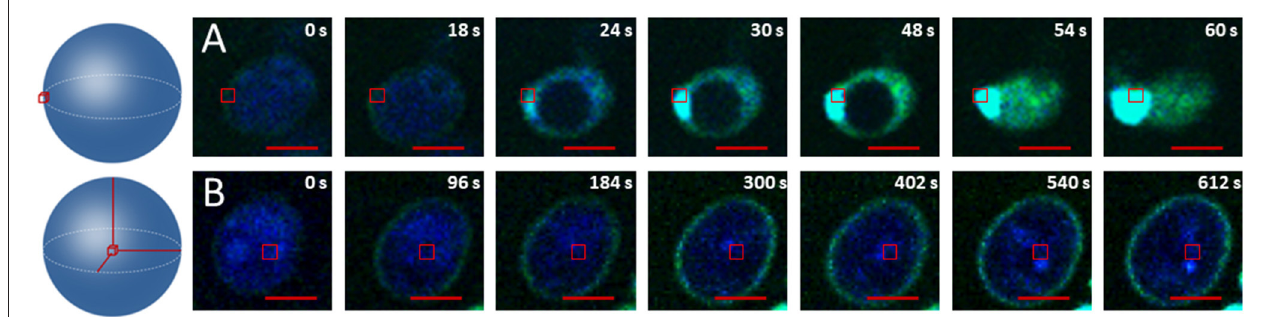
FIGURE 4 | Evolution of (A) time and (B) energy required to induce the permeabilization of the cells according to the power of the treatment. The black line represents the calculated curve fitting.